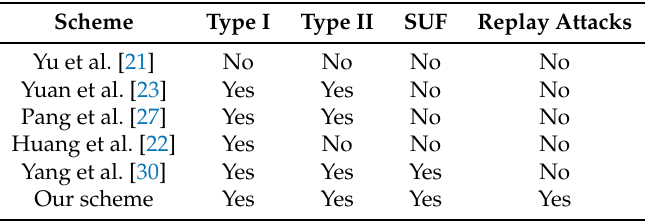
Table 2. A comparison of the security